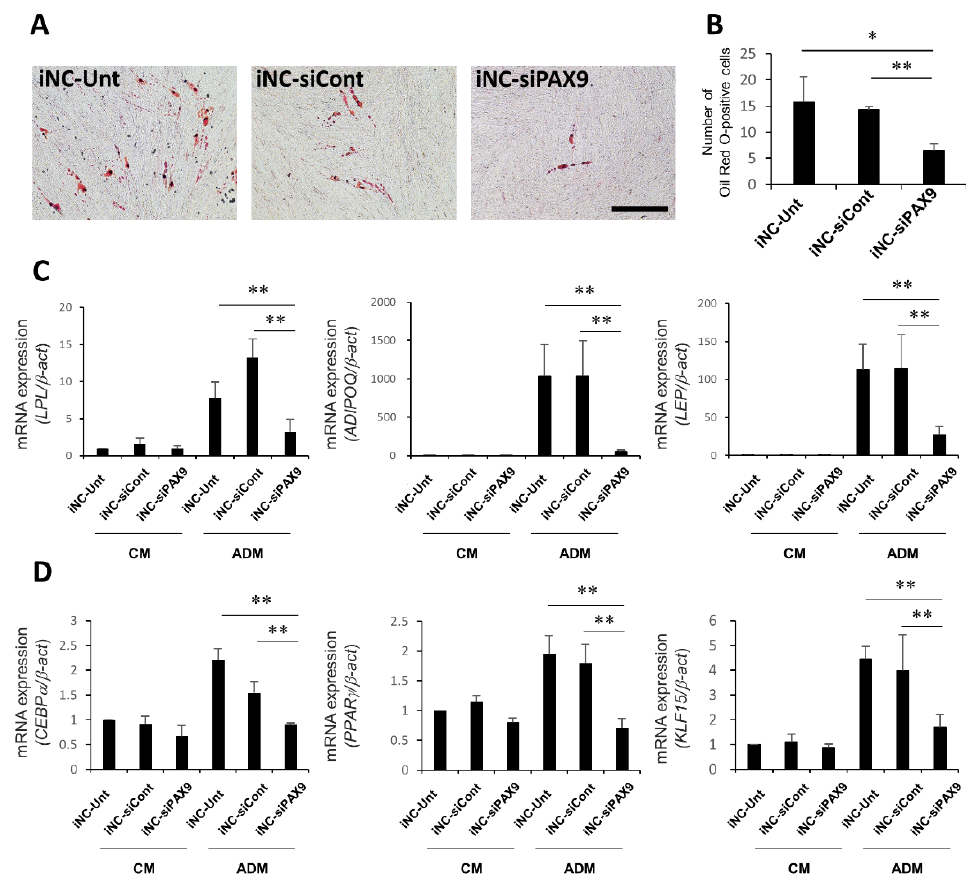
Figure 6. Limited adipocytic differentiation potential in iNC-siPAX9. ( A ) Representative Oil Red O-staining in iNC-Unt, iNC-siCont, and iNC-siPAX9 after 4 weeks of culture in ADM. Bar = 200 µ m. ( B ) Numbers of Oil Red O-positive cells in iNC-Unt, iNC-siCont, and iNC-siPAX9 cultured in ADM for 4 weeks. ( C , D ) Quantitative real time RT-PCR analysis of adipocyte marker genes LPL , ADIPOQ , and LEP ( C ) and adipogenesis regulator genes CEBP α , PPAR γ , and KLF15 ( D ) in iNC-Unt, iNC-siCont, and iNC-siPAX9 after 4 weeks of culture in CM or ADM. β -act was used as an internal standard. Data are portrayed as the mean ± standard deviation ( n = 4). * p < 0.05 ** p < 0.01. ADM, adipocytic differentiation medium; CM, conditioned medium; iNC, induced pluripotent stem cell-derived neural crest-like cells.